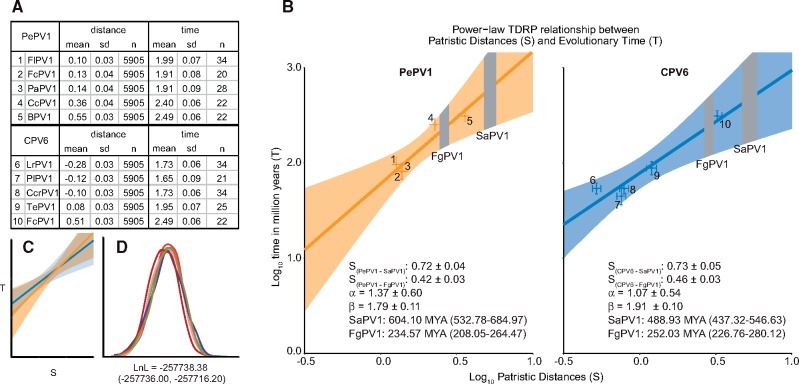
 Evolutionary timescale of FgPV1 estimated by using the power-law rate-decay model. (A) The power-law rate-decay model (T = αSβ) accounting for the time dependent rate phenomenon requires the patristic distance between different viruses (S) and the associated host divergence times (T) (Aiewsakun and Katzourakis 2017). To account for phylogenetic uncertainty, the post burn in posterior tree sample of three independent MrBayes (Huelsenbeck and Ronquist 2001; Ronquist and Huelsenbeck 2003; Ronquist et al. 2012) runs was used as the basis to calculate S (ntrees=5905). S values were derived by back calculating from CPV6 and PePV1. T estimates for host species pairs were downloaded from www.timetree.org (Hedges et al. 2006; Hedges et al. 2015). Individual S and T values were log10 transformed, the mean and SD is shown. (B) S and T mean values with associated standard deviation were plotted. The numbers by the data points refer back to panel (A). The gray bars show the associated error for the FgPV1 and SaPV1 S estimates. Deming regression was used to obtain mean (±SD) values for the alpha and beta parameters. To obtain real time estimates, the reverse log of the solved values is reported (mean with 95% confidence interval). The regression line and associated confidence interval were drawn using regular linear regression, and is for illustrative purposes only. (C) Overlay of the curves in B showing overlap of derived estimates. (D) Posterior distribution of log likelihood values showing that the three separate MrBayes analyses converged on the same solution.